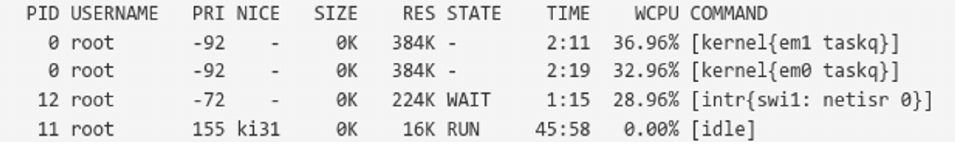
Figure 10. System load of the routers during the attack—GW and WAN